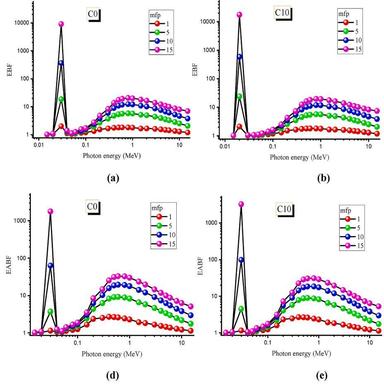
Variation of exposure buildup factor (EBF) energy absorption buildup factor (EABF) values at different photon energies.